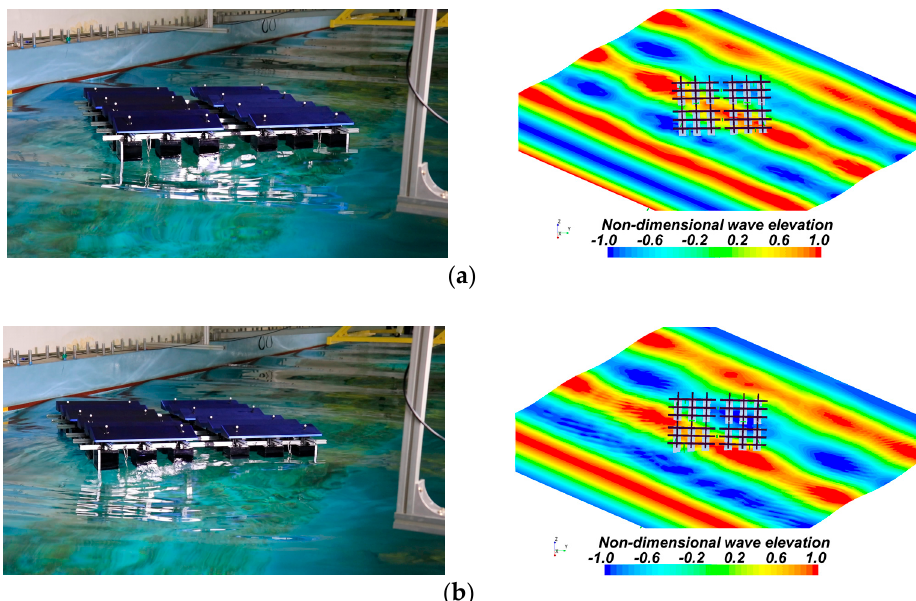
Figure 26. Wave pattern of experiment ( left ) and computation ( right ) according to the wavelength under oblique sea: ( a ) 𝝀/𝑳 𝒖𝒏𝒊𝒕 = 2.4; ( b ) 𝝀/𝑳 𝒖𝒏𝒊𝒕 = 2.8.